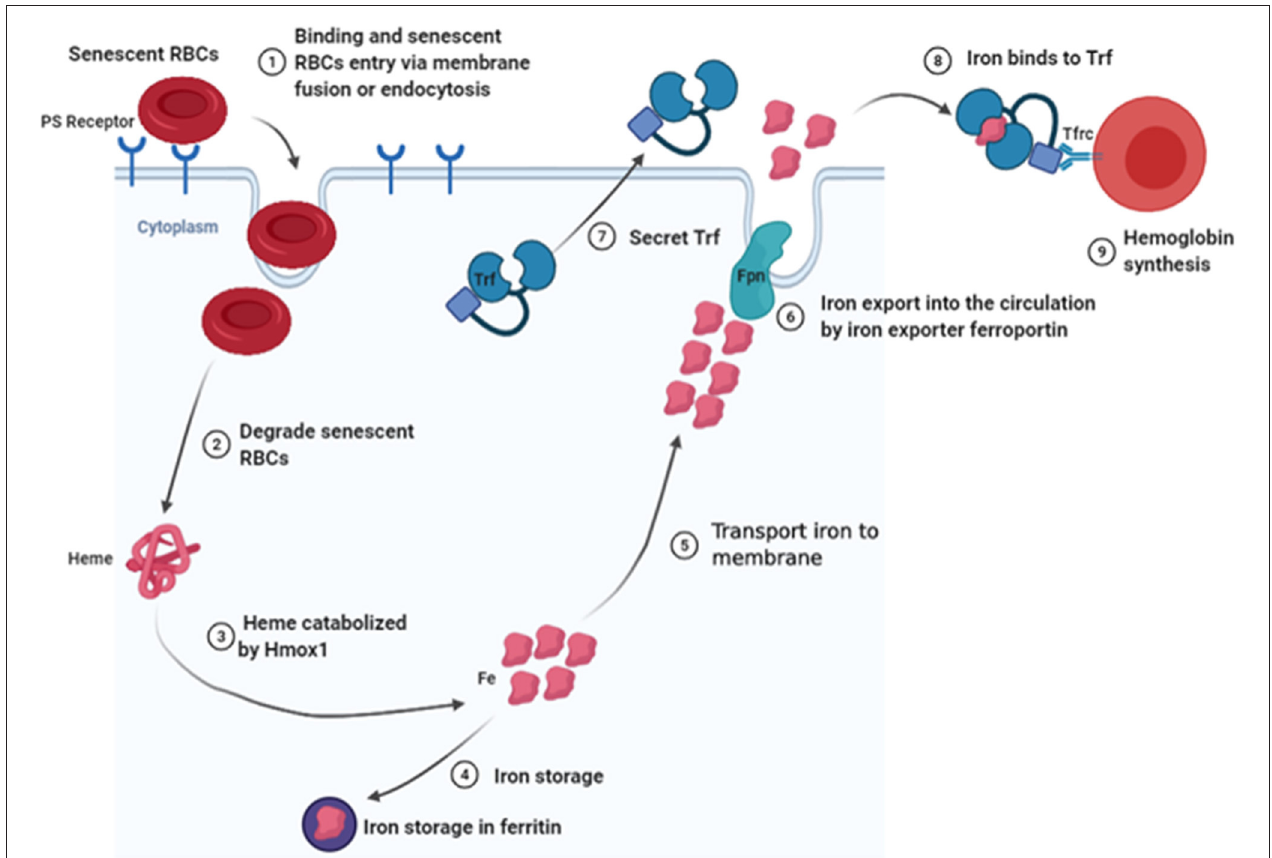
FIGURE 3 | Schematic diagram of senescent RBC clearance and iron recycling by EBI macrophages in local BM microenvironment.